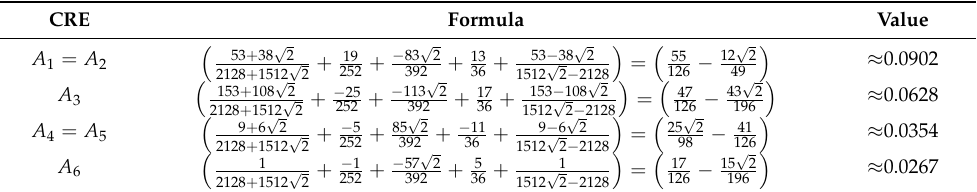
Table 2. Circuit resonance energy (CRE) values, A C , calculated using Equation (2) for cycles of anthracene. Cycles are labelled as shown in Table 1.